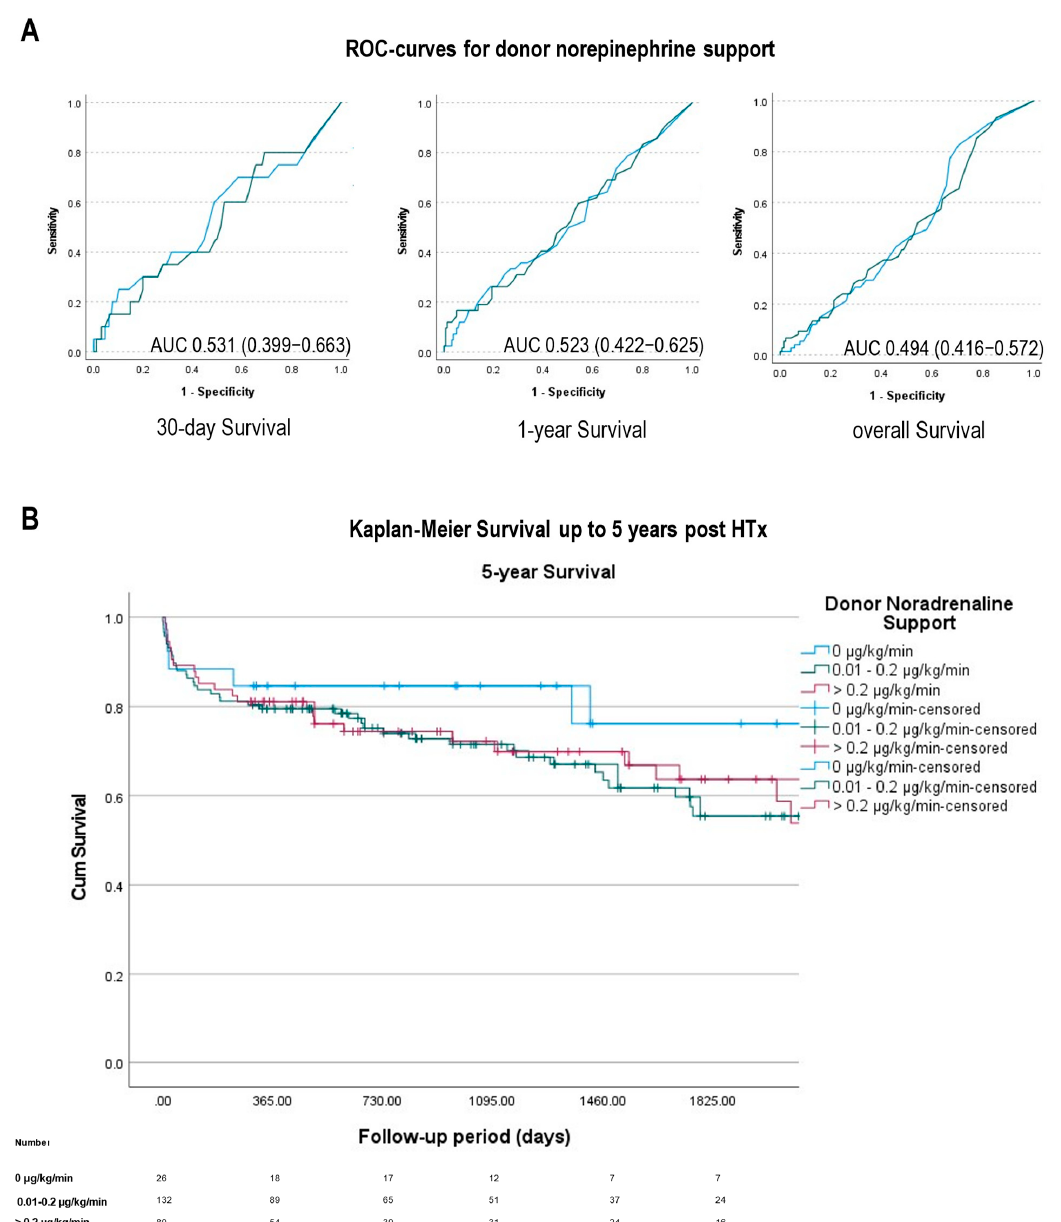
Figure 1. Association of donor norepinephrine support and survival. ( A ) Receiver operating characteristics (ROC) analysis for 30-day, 1-year, and overall survival. The area under the curve (AUC) showed no association for either 30-day (AUC 0.531), 1-year (AUC 0.523), or overall survival (AUC 0.494). ( B ) Kaplan-Meier survivals for no (0 µ g/kg/min, n = 26), medium (0.01–0.2 µ g/kg/min, n = 132), or high (>0.2 µ g/kg/min, n = 80) donor noradrenaline support prior to heart transplantation. Data under the graph representing patients at risk at specific time points in all groups. Log Rank p =